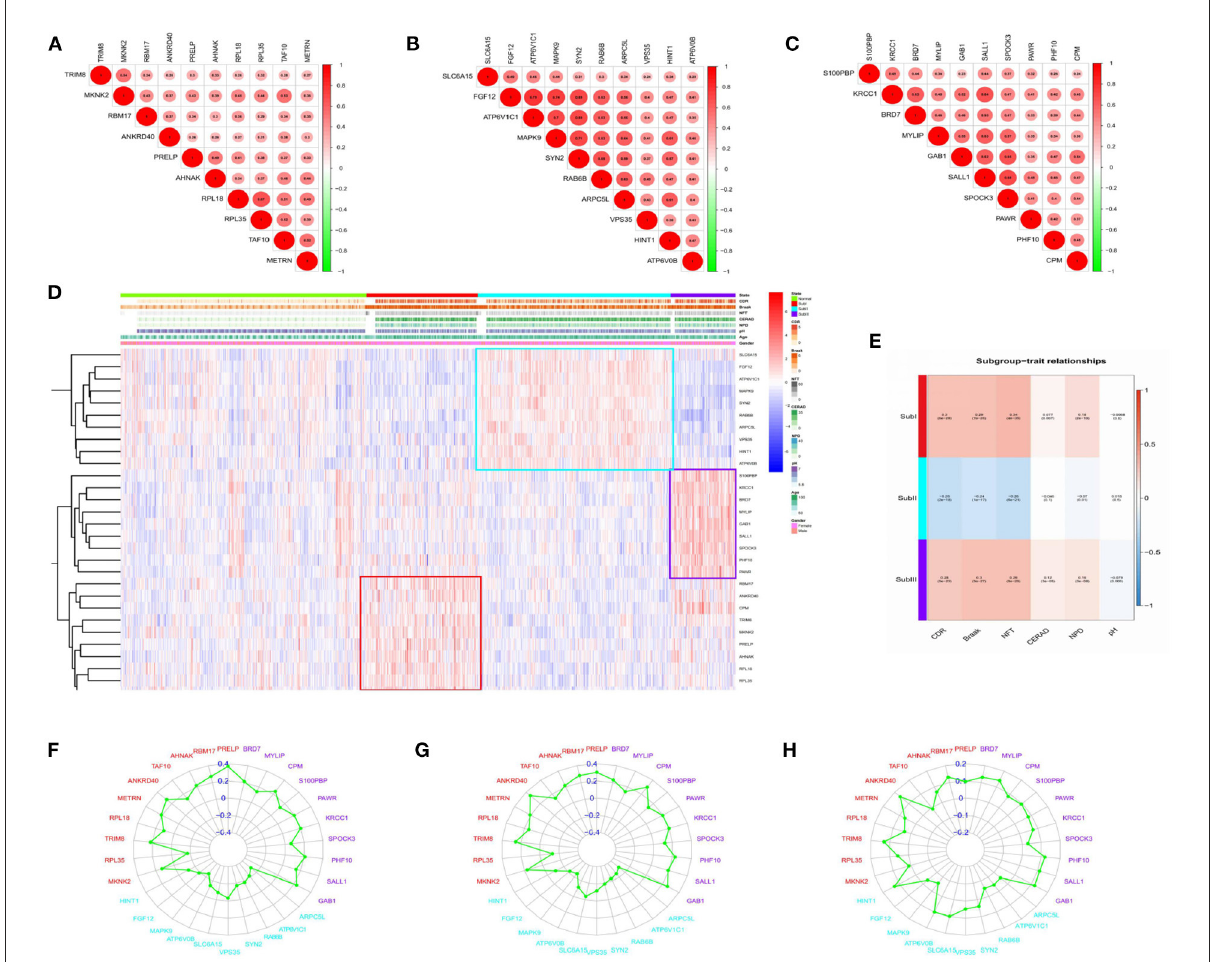
FIGURE10 Correlation analysis. (A) Gene-to-gene interactions in subgroup I. (B) Gene-to-gene interactions in subgroup II. (C) Gene-to-gene interactions in subgroup III. The size and color of the circle reflect the magnitude of the interaction, with larger size and darker color illustrating that the interaction has been reinforced. (D) Clinical relevance heatmap of single-gene. Red represents high expression. Blue represents low expression. White means no difference. (E) Subgroup-trait relationship of combination-gene in each subgroup. Red represents high expression. The number above the parentheses represents the correlation. The number in parentheses represents the P -values. Blue represents low expression. White means no difference. (F) Correlation analysis between hub genes and CDR in each subgroup. (G) Correlation analysis between hub genes and NFT in each subgroup. (H) Correlation analysis between hub genes and NPD in each subgroup.